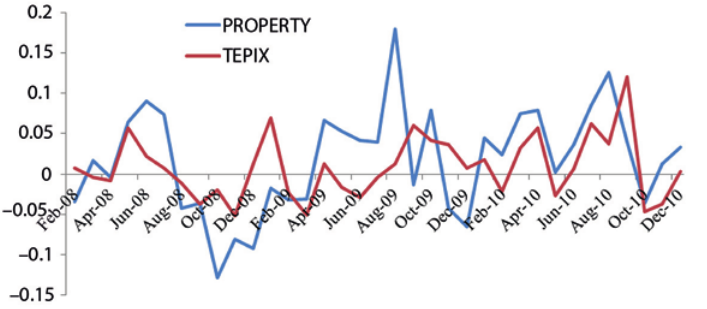
Figure 1. return on Market Price Index (tePIX) and return on Property Stock Price Index (ProPerty) Source: Iran’s tehran Stock